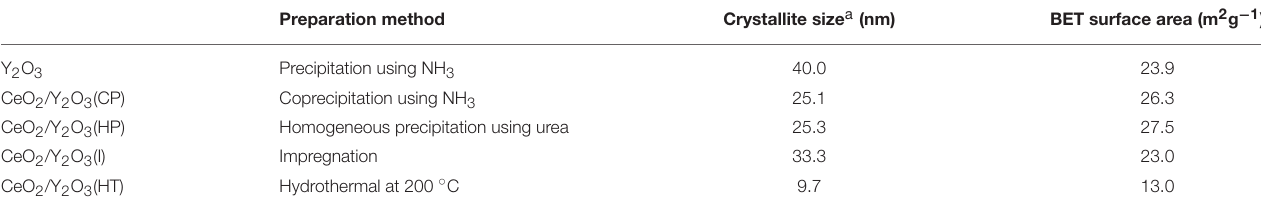
TABLE 1 | Physico-chemical properties of CeO 2 /Y 2 O 3